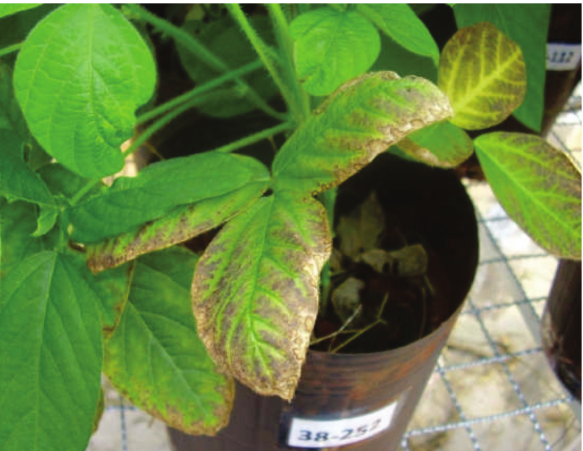
Figura 5. Sintomas de toxidez de B em plantas de soja cultivada em Latossolo Vermelho eutroférrico de textura arenosa com a aplicação de 2 mg kg -1 desse